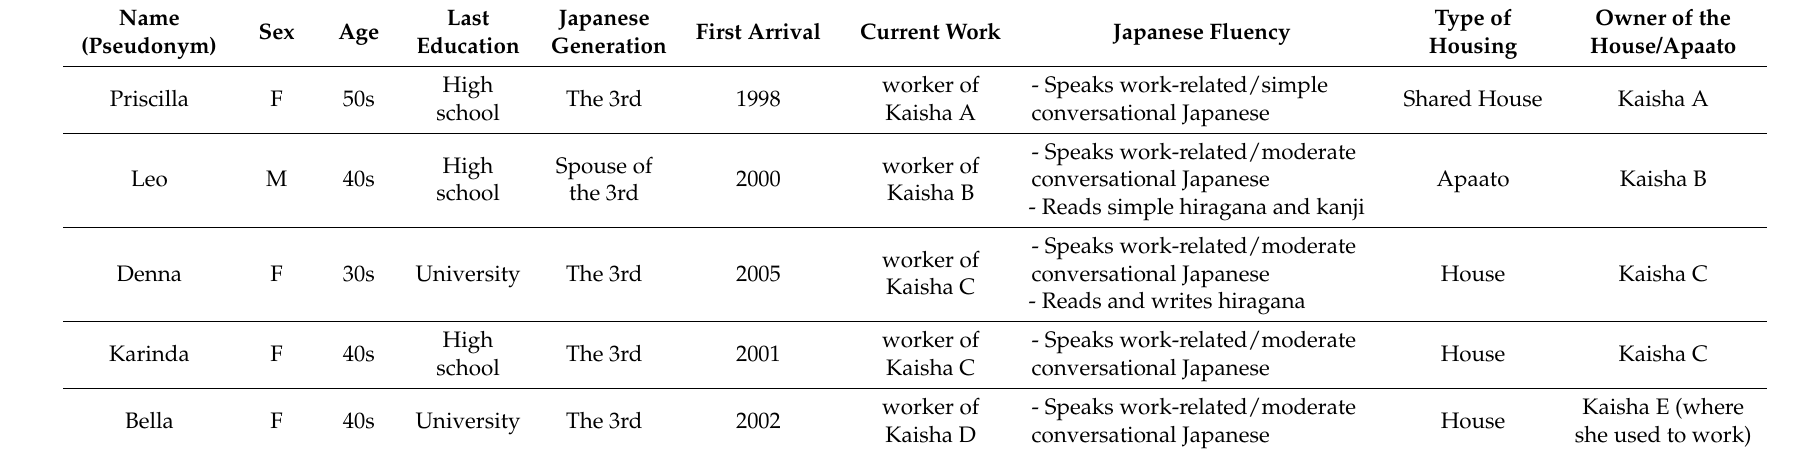
Table 2. Five participants’